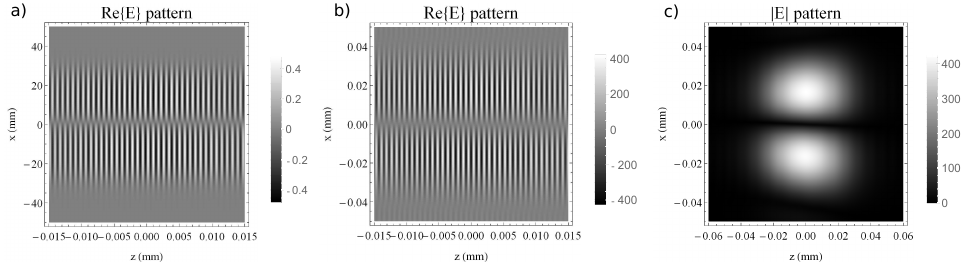
on x Figure 5. The field profile ( Re E z at t = 0 and y = 0) of the chirped laser, with duration { } − τ = 4 τ F after being reflected by the helical mirror ( a ) in the NF and ( b ) in the focal region of an f = 1500 mm mirror (the back focal plane is considered in z = 0 for simplicity). ( c ) The corresponding amplitude profile ( on x E z at t = 0 and y = 0) for the focused field shown in plot ( b | | −